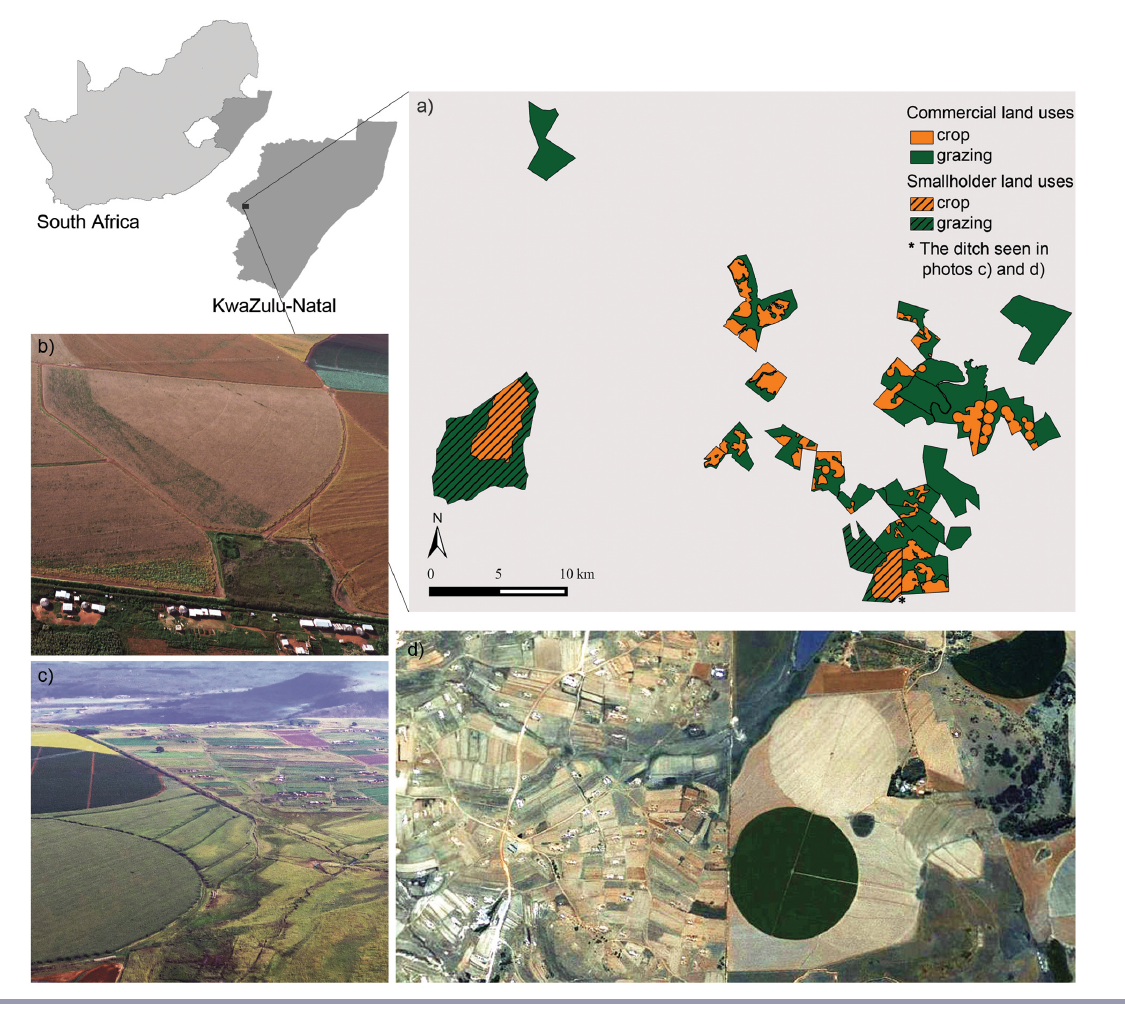
Fig. 1 . Illustrations of the study area in the Drakensberg mountain range in South Africa. (a) The landholdings and land uses (cropland and grazing land) belonging to the 10 large-scale commercial farmers and the 2 smallholder villages. (No other land uses are displayed to avoid identification of individual farm locations and to assure confidentiality of the respondents.) (b and c) Smallholder and commercial croplands divided by the ditch portrayed in the introduction. Photos taken by R. Malinga (2009). (d) A satellite image of the ditch separating 1 smallholder village and 1 commercial farm, from Google Earth